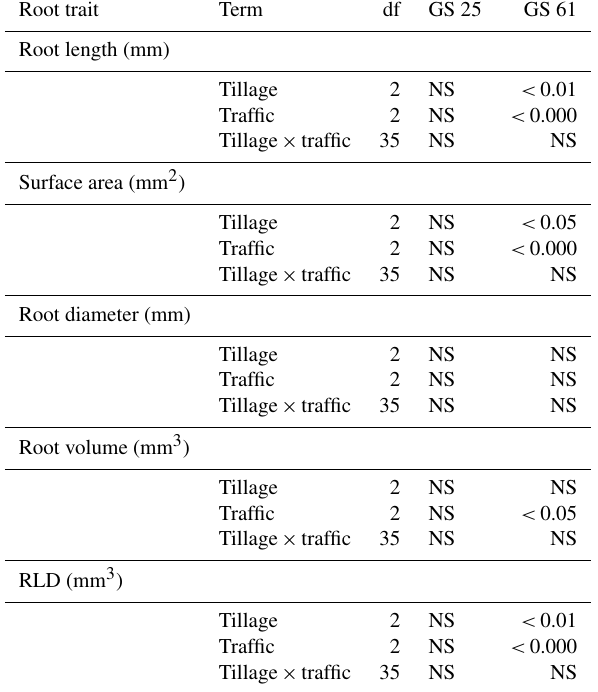
Table 5. WinRHIZO™ results of tillage, traffic, and tillage × traffic interactions with root traits at HAU during tillering (GS 25) and anthesis (GS 61). P values represent the level of significance, “NS” indicates non-significance, and df represents degrees of